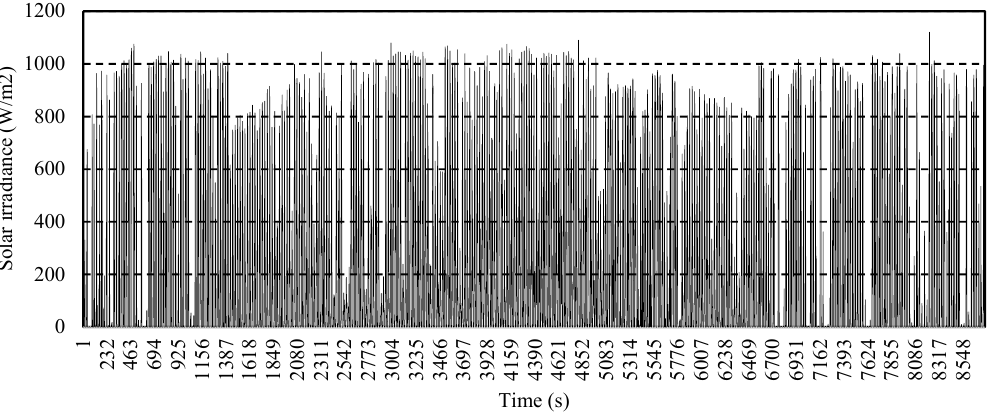
Figure 4. Solar irradiance for one year.